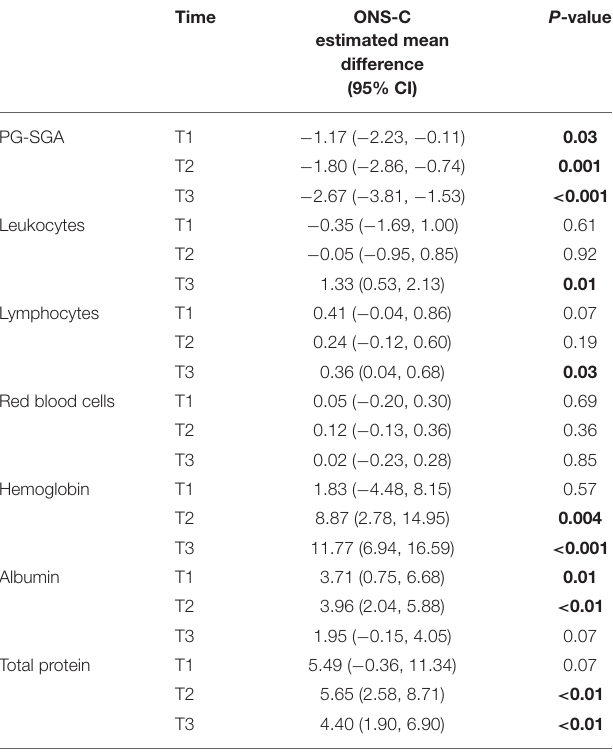
TABLE 3 | GEE model estimates of the differences in changes from baseline (mean change with confidence intervals) in nutritional risk and biomarkers between groups across time ( n = 60).